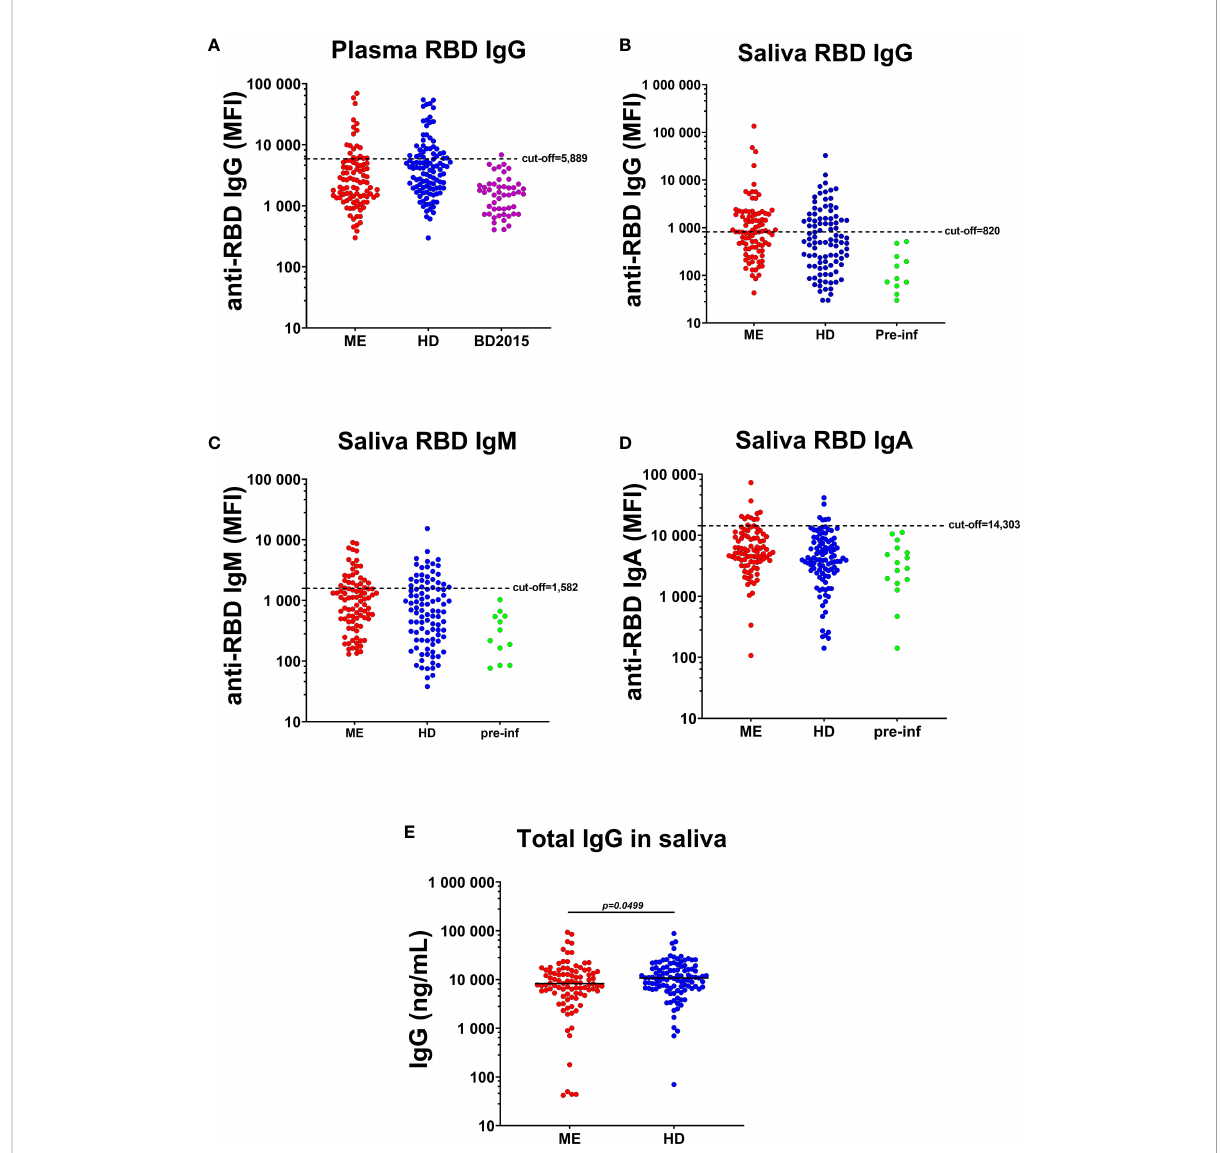
FIGURE 1 Plasma and saliva antibody responses against SARS-CoV-2-RBD (RBD). (A) IgG in plasma of patients with ME/CFS (ME), healthy donors (HDs) and blood donors collected before COVID-19, during 2015 (BD2015). Antibody responses against RBD in the saliva of ME, HD and a group of study participants seroconverted during the course of the study (pre-infection donors, pre-inf), for (B) IgG, (C) IgM and (D) IgA class. Cut-off threshold levels used to de fi ne SARS-CoV-2 positive/negative subgroups are indicated with dashed horizontal lines. For IgG responses in plasma, cut-off level was calculated from BD2015 IgG levels (BD2015, n=50; mean MFI + 3SD = 5889 MFI). For antibody responses in the saliva, cut-off levels were calculated from antibody titers of pre-inf donors (n=19; mean MFI + 3SD = 820 MFI for IgG, 1582 MFI for IgM and 14303 for IgA). (E) Concentration of total IgG (ng/mL) in the saliva of patients with ME (n=95) and HDs (n=110). Lines represents mean MFI (median fl uorescence index). Statistically signi fi cant difference was calculated by nonparametric Wilcoxon